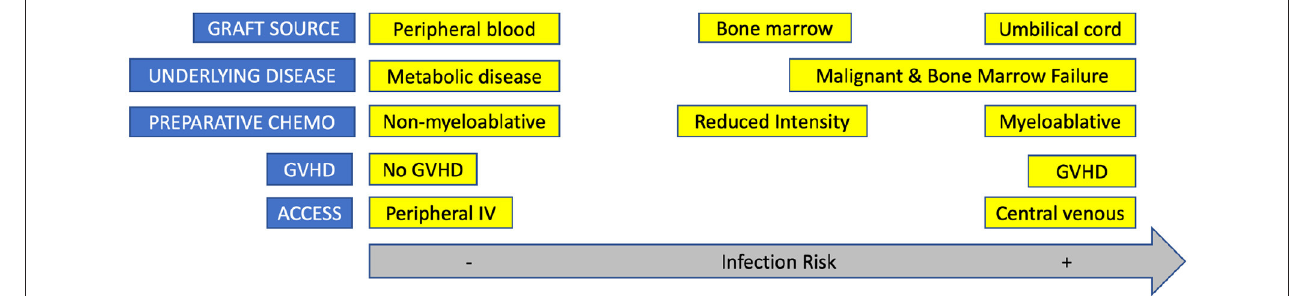
FIGURE 3 | HCT characteristics and risk for